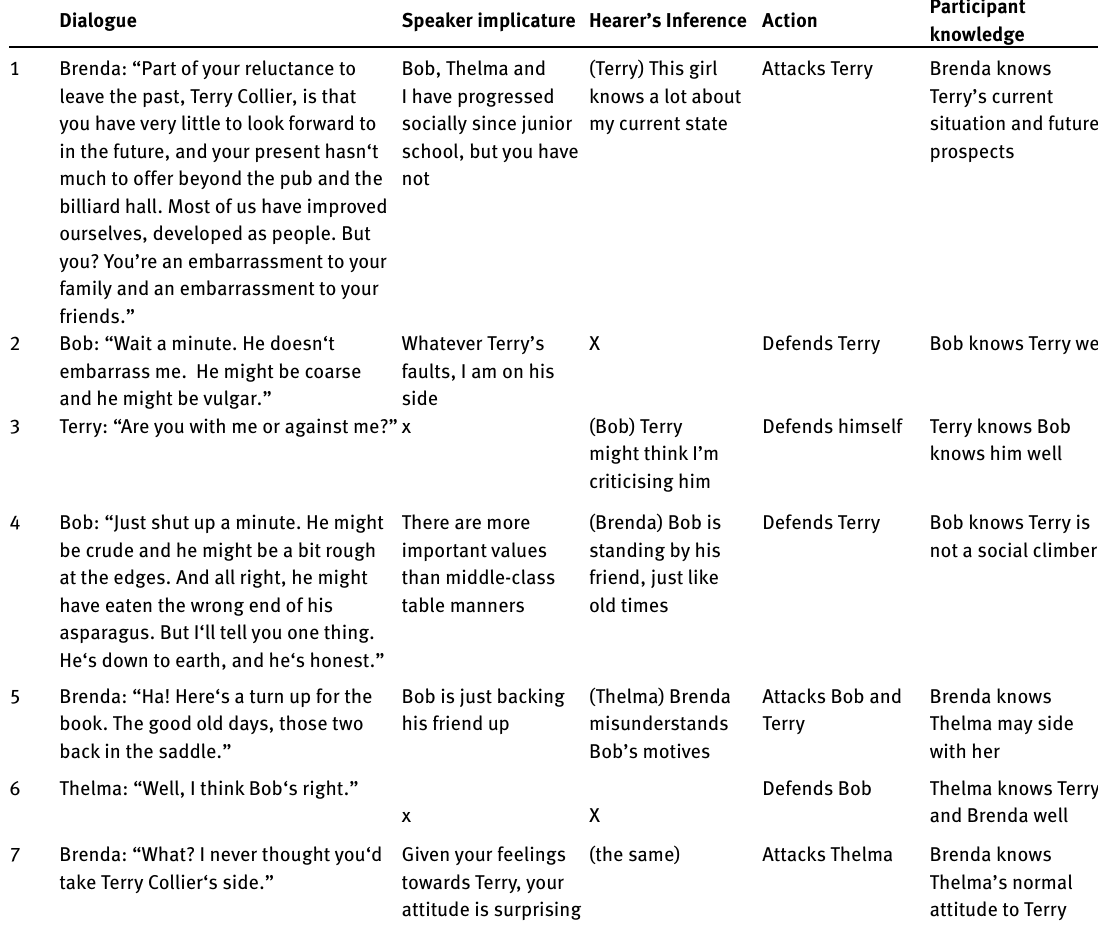
Table 4: ‘Guess who’s coming to dinner’, extract 4